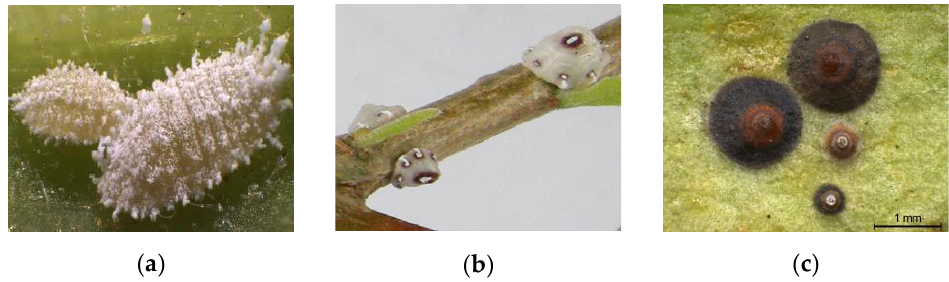
Figure 6. The three types of pest images identified in this study. ( a ) Mealybugs (RF). ( b ) Coccidae (RR). ( c ) Diaspididae